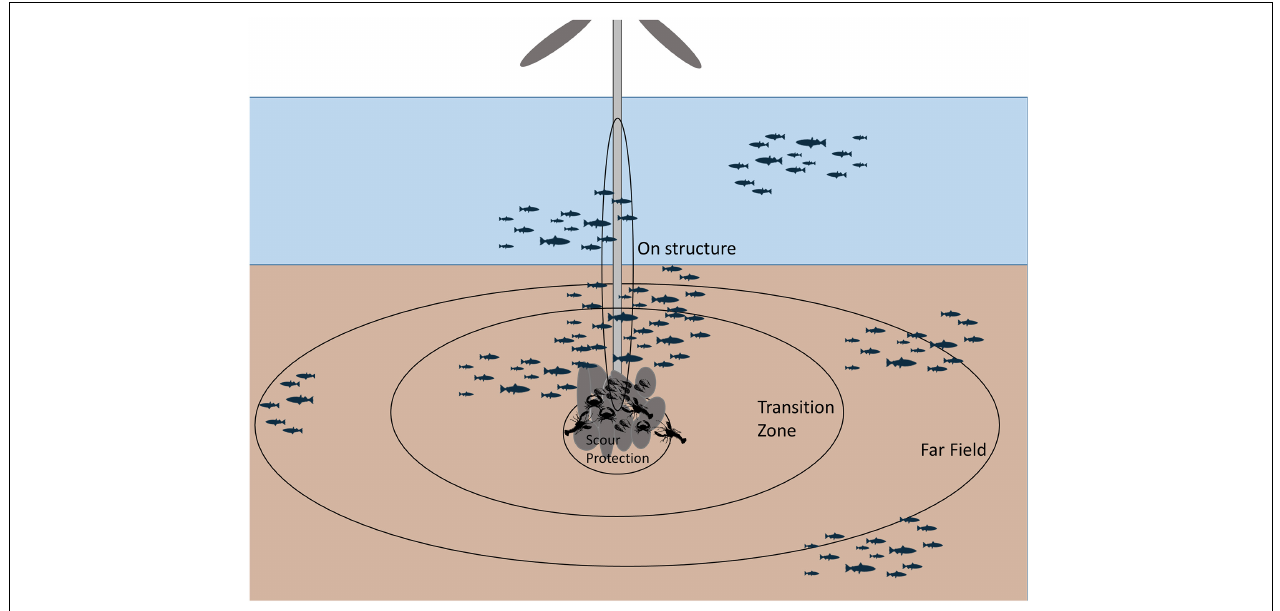
FIGURE 3 | Diagram of gradient-based sampling design with data collected on-structure, within the scour protection, within a transition zone, and at a far-field